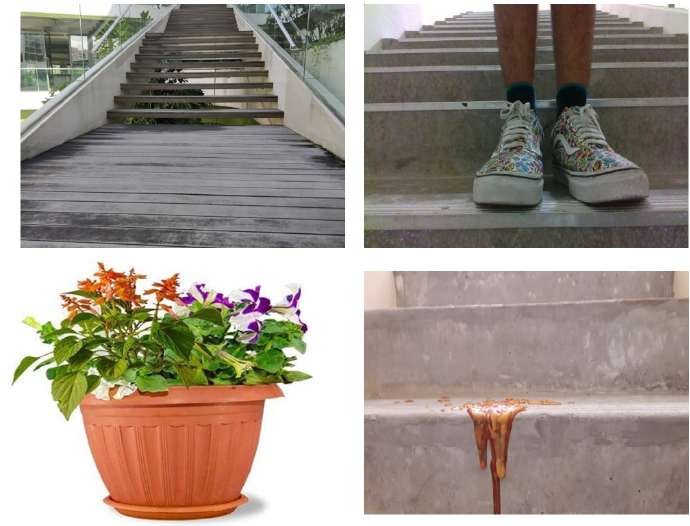
Figure 9. dataset.